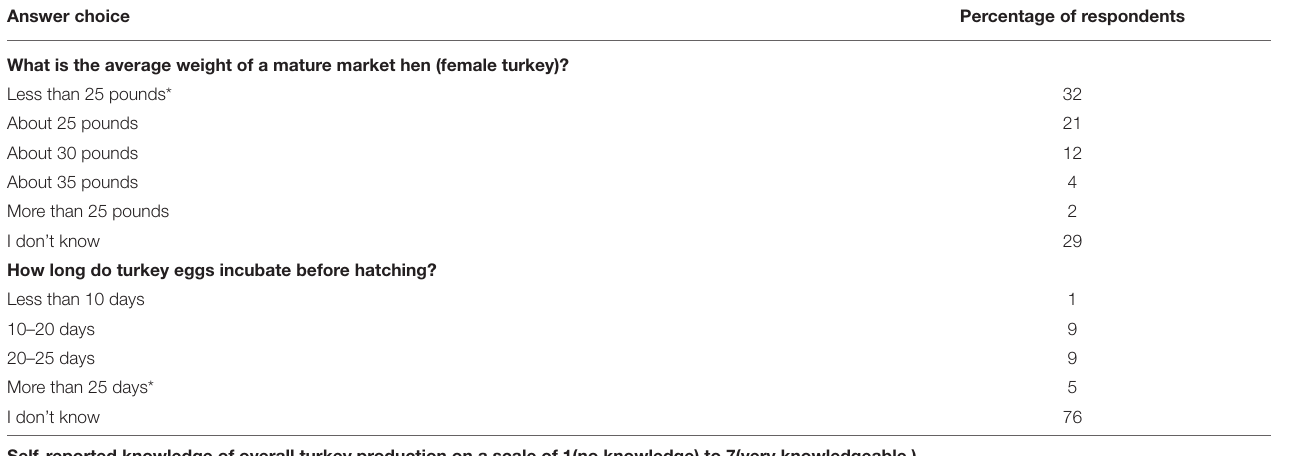
TABLE 5 | Responses to turkey production questions ( N =